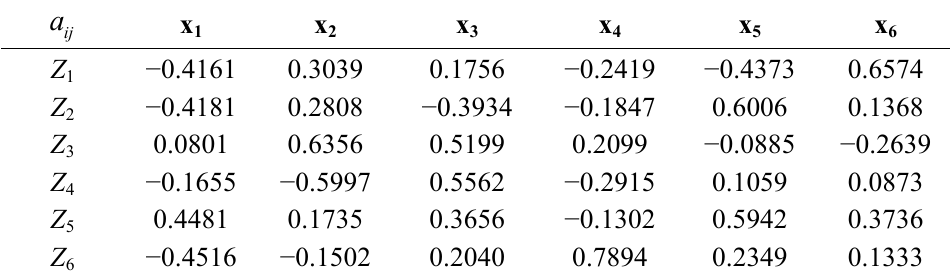
Table 3. Calculation results of the principal component matrix Z .